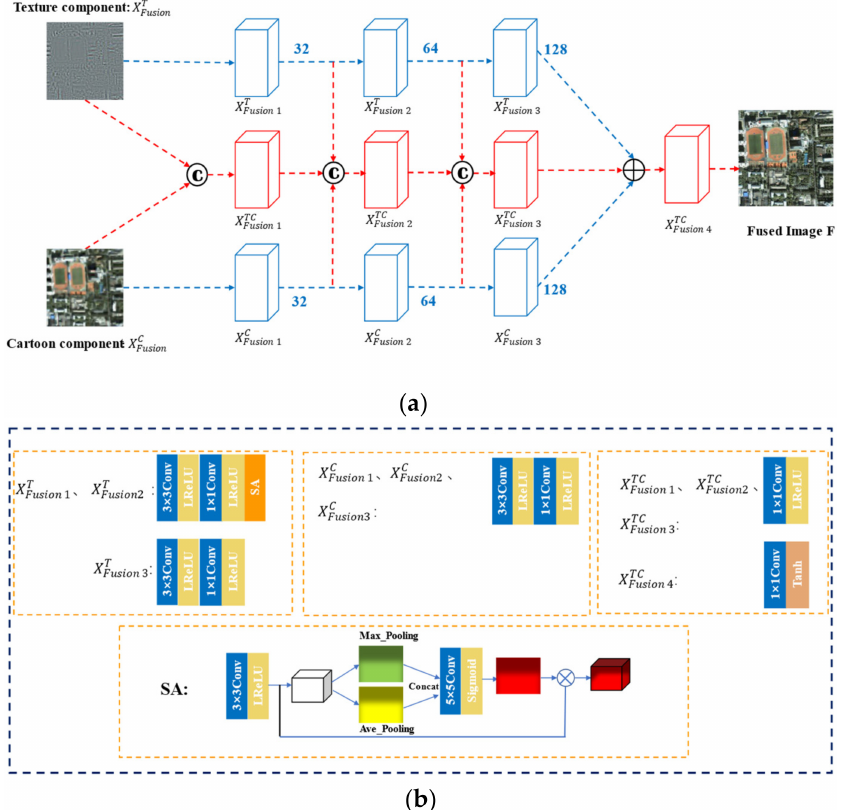
Figure 5. The overall frame diagram of the fusion network and structure details. ( a ) The overall frame diagram of the fusion network; ( b ) The structure details of the